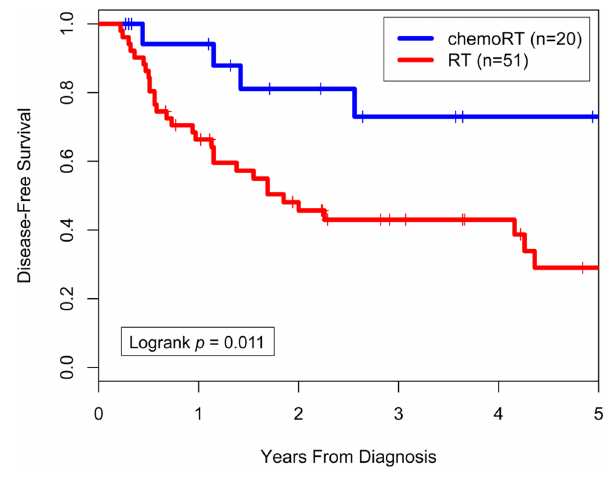
Figure 2. Disease-free survival by treatment (chemoradiation therapy or radiation therapy